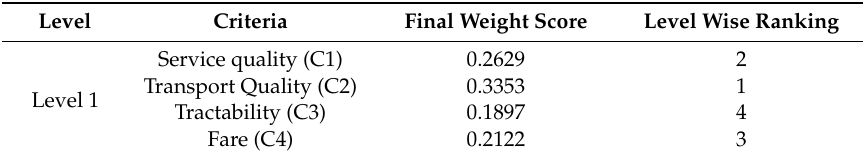
Table 4. Priority ranking for level